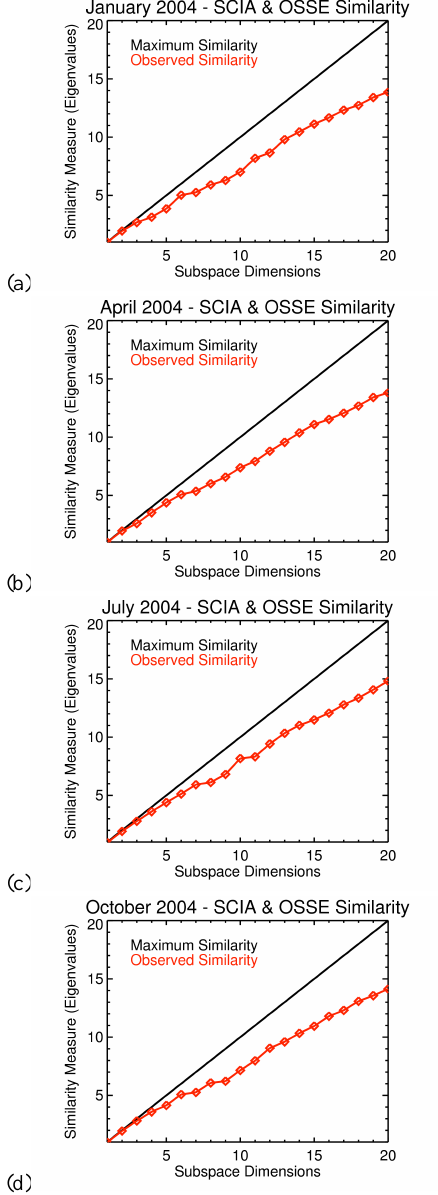
Fig. 6. The comparison of the eigenvalues from the spectral decom- position of the intersection to the maximum possible eigenvalue for each number of subspace dimensions. As more dimensions are used to define the subspaces, the similarity identified by the eigenvalues